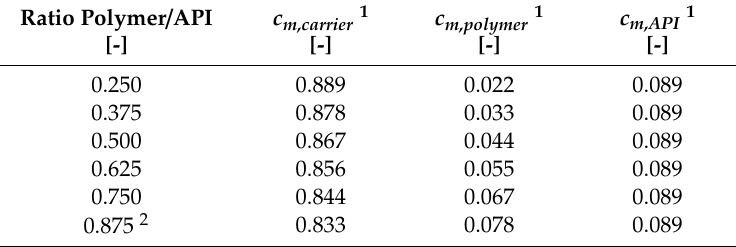
Table 2. Polymer to active pharmaceutical ingredient (API) ratios and resulting mass fractions of carrier material, polymer, and API in the